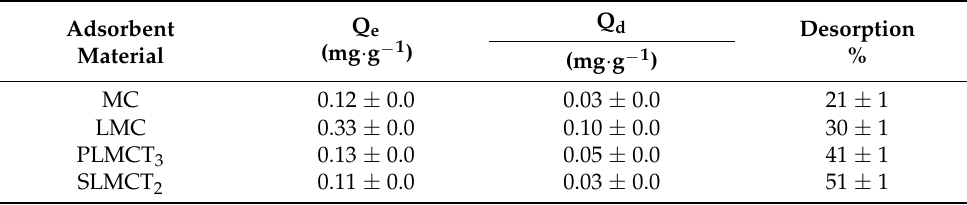
Table 6. Desorption of phosphate bonded to the adsorbents. Adsorbent